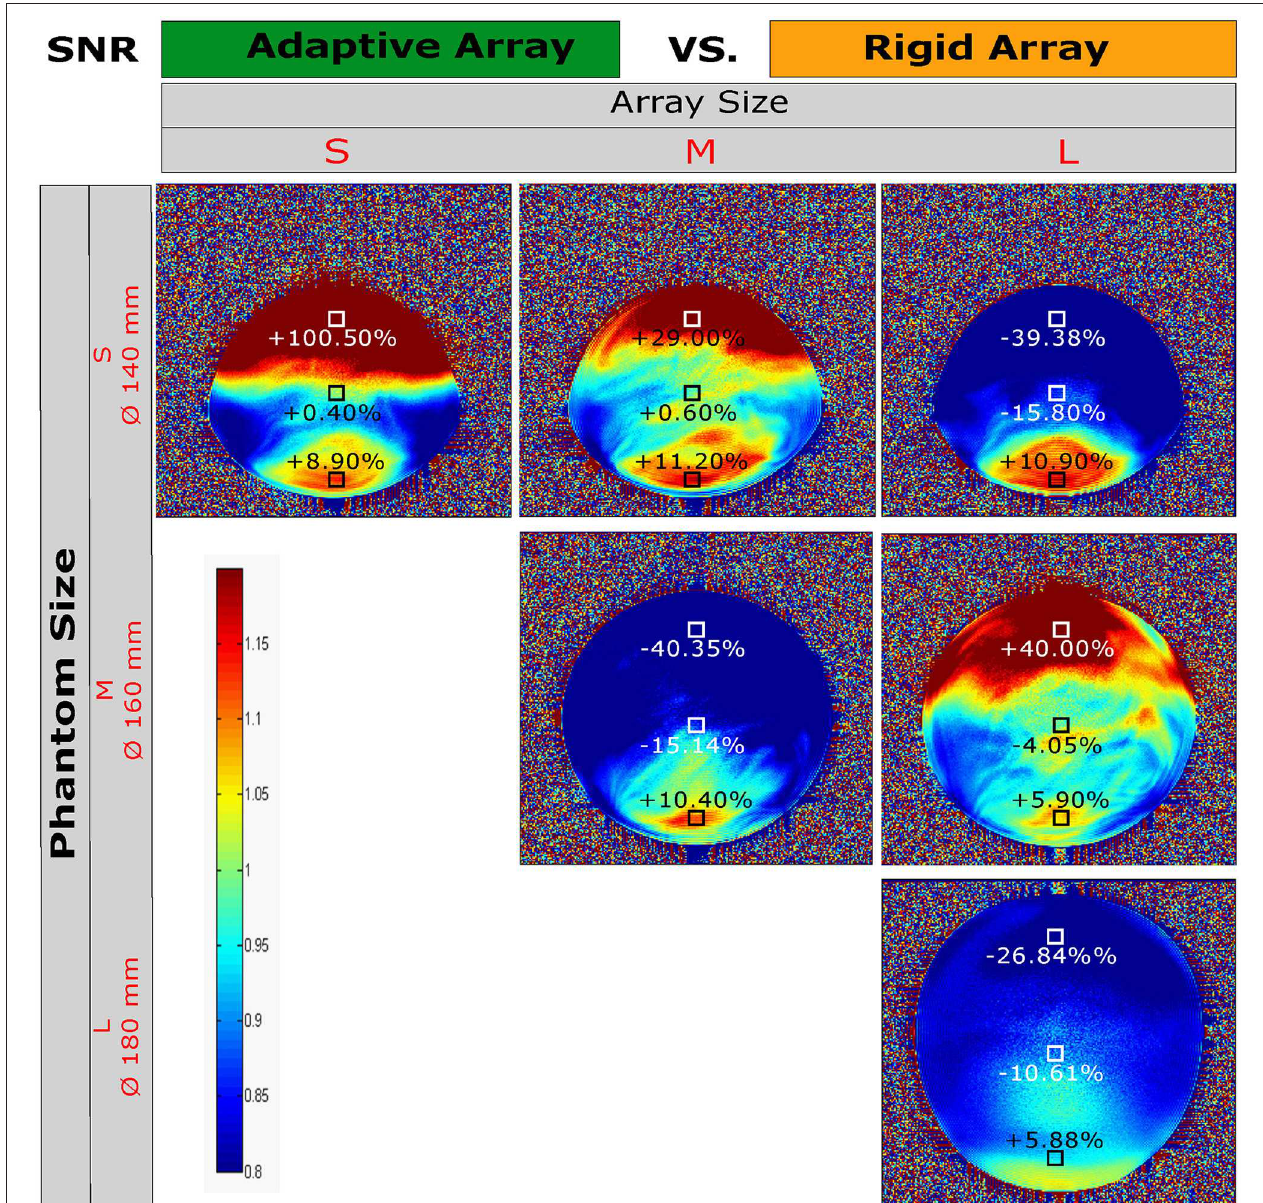
FIGURE 8 | SNR images of the adaptive and the rigid knee array compared to each other using different phantom (knee) sizes. A SNR gain or loss at the ROI is indicated with “ ” and “ ” symbol and the corresponding percentage + −